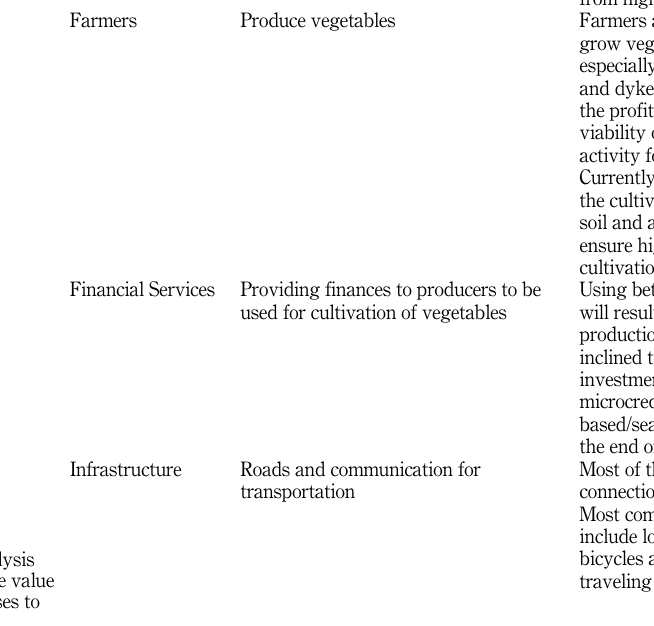
Table 10. Constraints analysis for the vegetable value chain in responses to climate